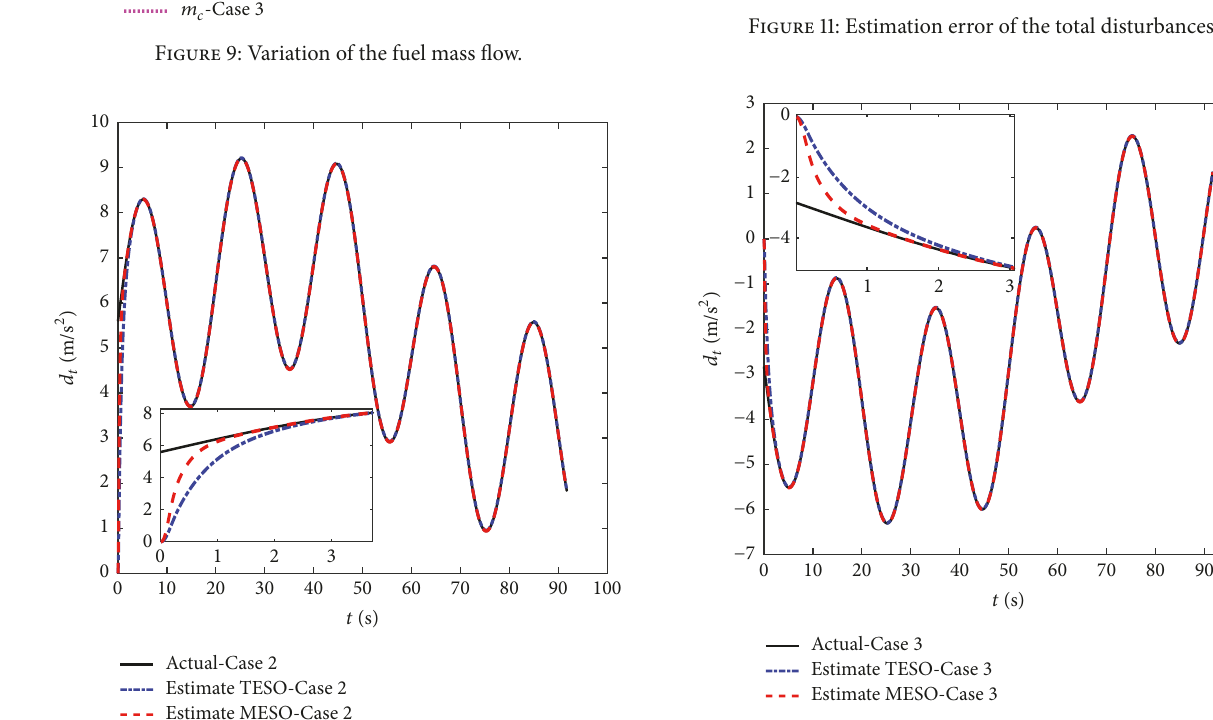
Figure 12: Estimations of the total